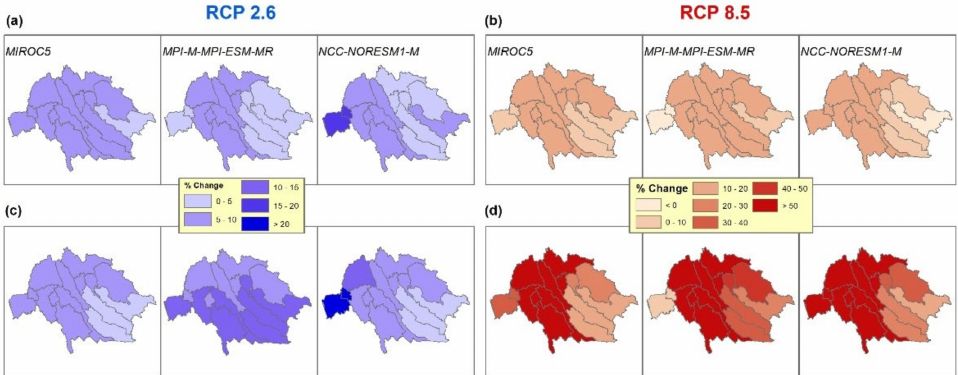
Figure 4. Percentage change in precipitation under RCP 2.6 ( left ) and RCP 8.5 ( right ) of three RegCM4 RCMs (from left to right MIROC5, MPI-M-MPI-ESM-MR, and NCC-NORESM1-M) compared with the baseline period (1991–2005) over each sub-basin of the Kalu River Basin. Two future periods are presented for each plot: 2046–2065 ( a , b ) and 2081–2099 ( c , d